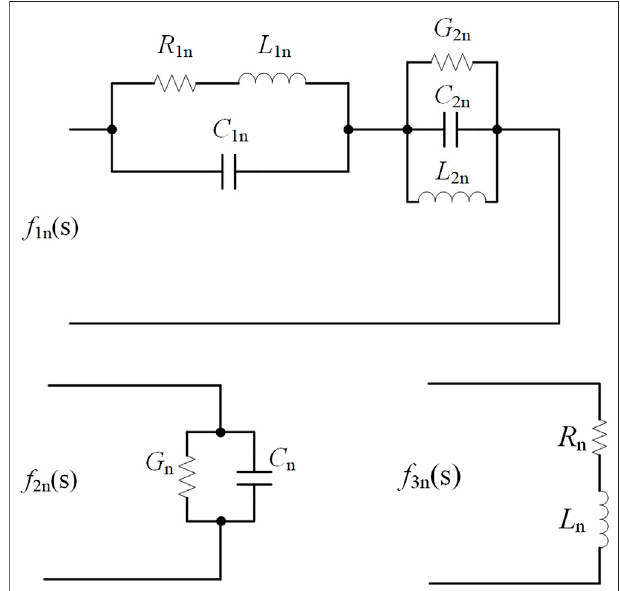
FIGURE 1 | Circuit forms of